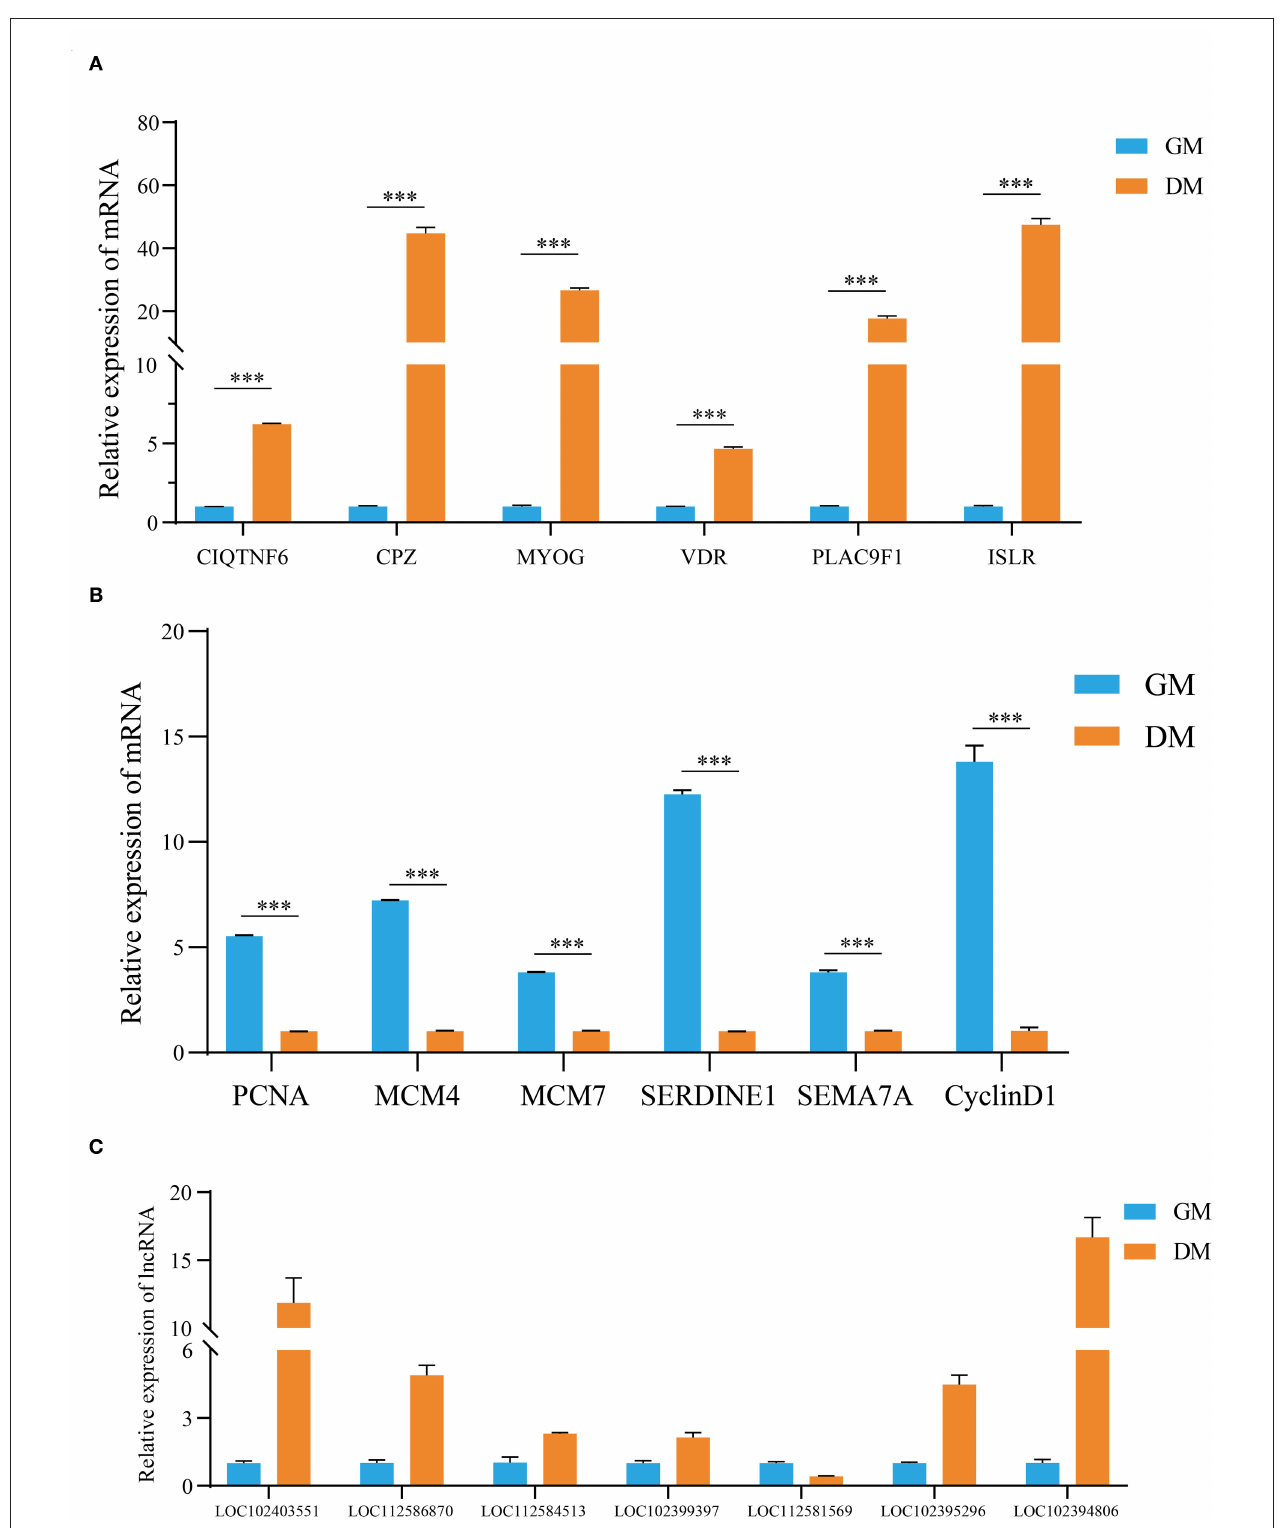
FIGURE 5 | Validation of the expression levels of DEGs, DE lncRNAs by RT-qPCR. (A,B) The validation results of DEGs and (C) DE lncRNAs. The data are present as means ± SDs, n = 3 per group. *** P < 0.001.